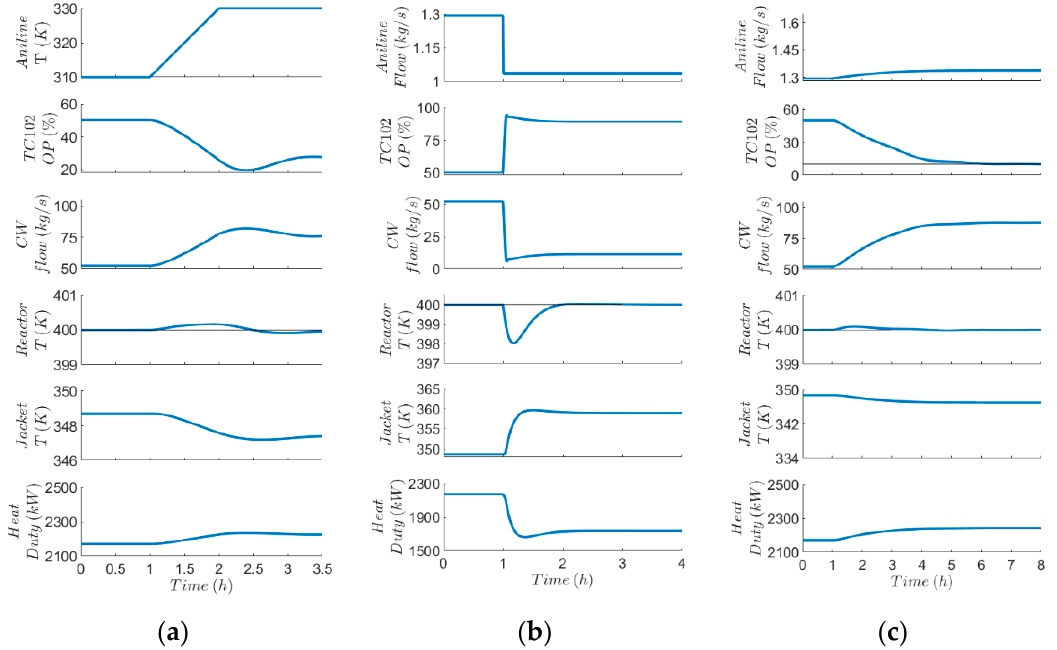
Figure 9. Control performance of plant Design B under ( a ) Scenario 1, ( b ) Scenario 2, and ( c ) Scenario 3.